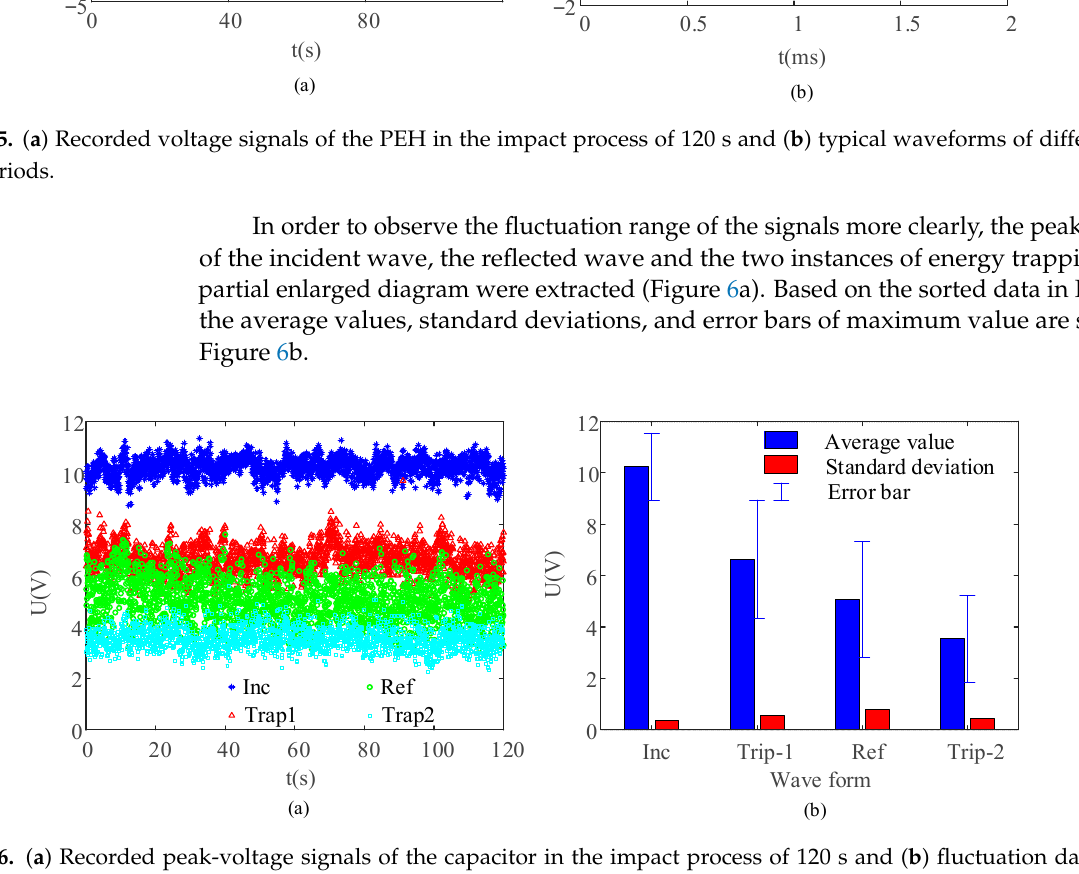
Figure 7. Influences of external resistance on ( a ) voltage and current peaks and ( b ) power. The peak voltage decreased with the increase in external resistance, whereas the peak current showed the opposite trend (Figure 7a). With the increase in external resistance, the maximum output power firstly increased and then decreased (Figure 7b). When the external resistance was about 30 k Ω , the maximum power reached 1.05 mW. Figure 8a–c show the open circuit voltage signals generated by the PEH under the three arrangement modes of particle chains under a fixed peak value of the open circuit voltage, which was 10 V. Energy storage capacitors were charged separately and the volt- age at both ends of the capacitor was measured every 10 min. Figure 8d shows the trend in the voltage at the ends of the capacitor within 180 min. When the three kinds of particle chain arrays shown in Figure 8a–c were excited, due to inevitable system error, the peak voltage of the open circuit voltage signal generated by each particle chain was not the same. Therefore, when more than one particle chain was excited simultaneously, it was only necessary to ensure that the highest peak voltage of all harvesting signals was 10 V. By increasing the number of particle chains, the energy harvesting effect was significantly improved, but the voltage at the ends of the energy storage capacitor did not change linearly with the increase in the number of particle chains (Figure 8d). It was impossible to ensure that the peak voltage of the signal generated by